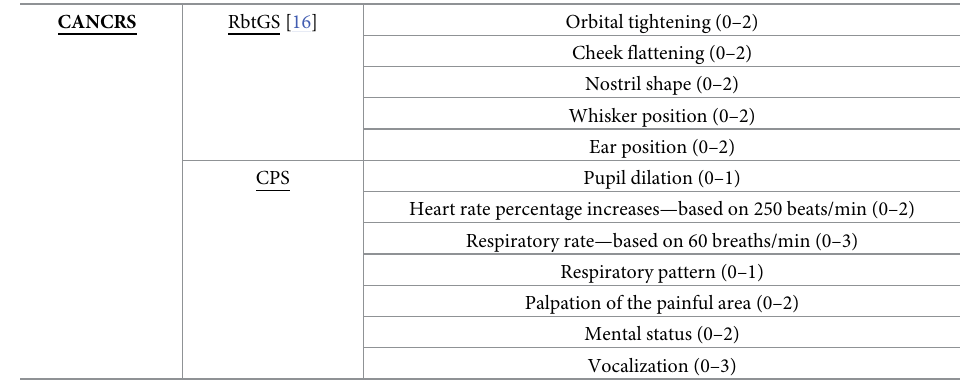
Vocalization (0–3)